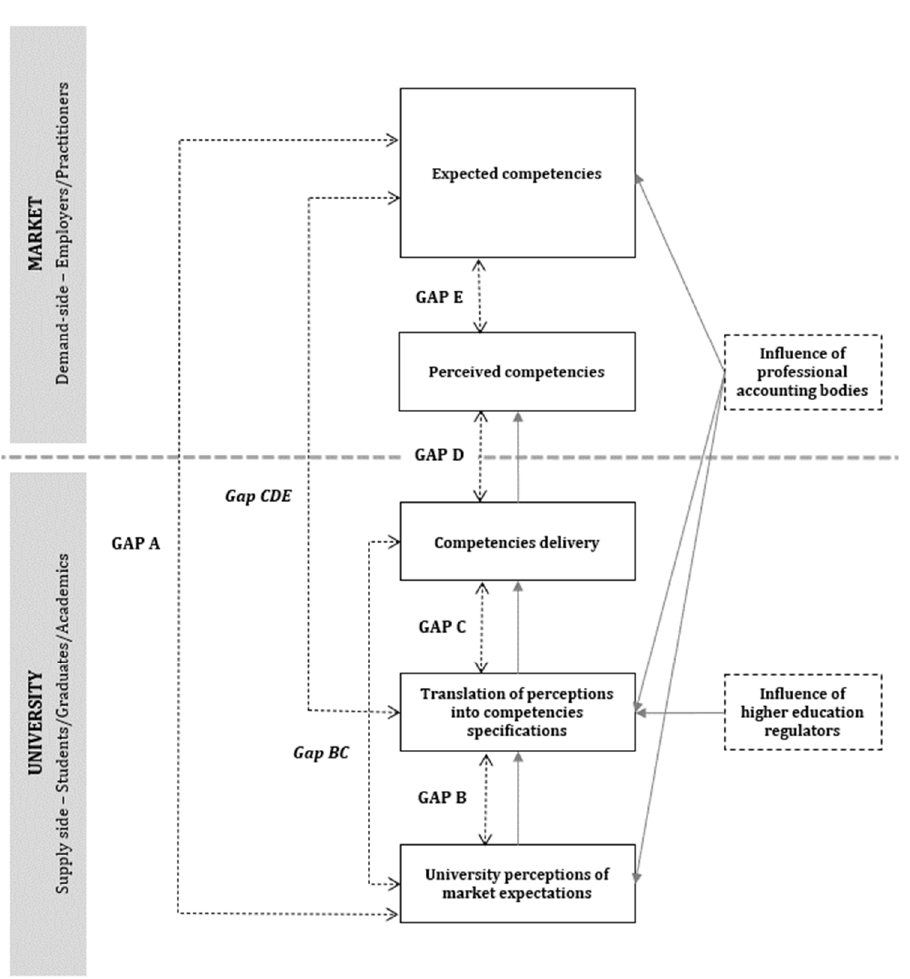
Figure 2. Conceptual model of the university–market adjustment of accounting professional’s com- petencies (Kroon and Alves